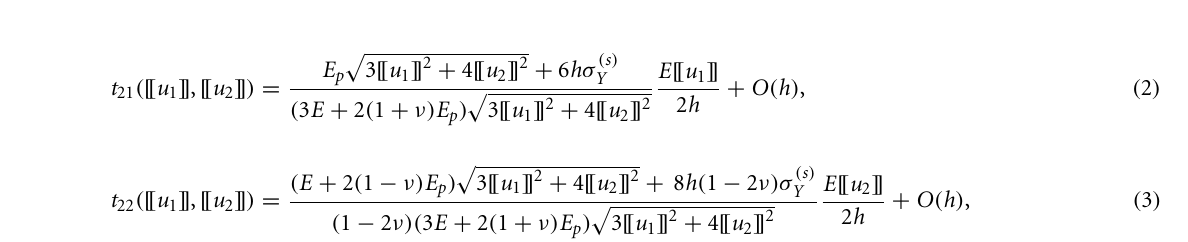
same von Mises plasticity model represented by the uniaxial stress behavior reported in (B) , but having a different yield stress (lower inside than outside the shear